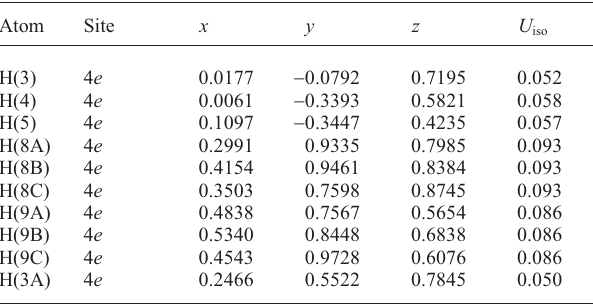
Table 2. Atomic coordinates and displacement parameters (in Å 2 )